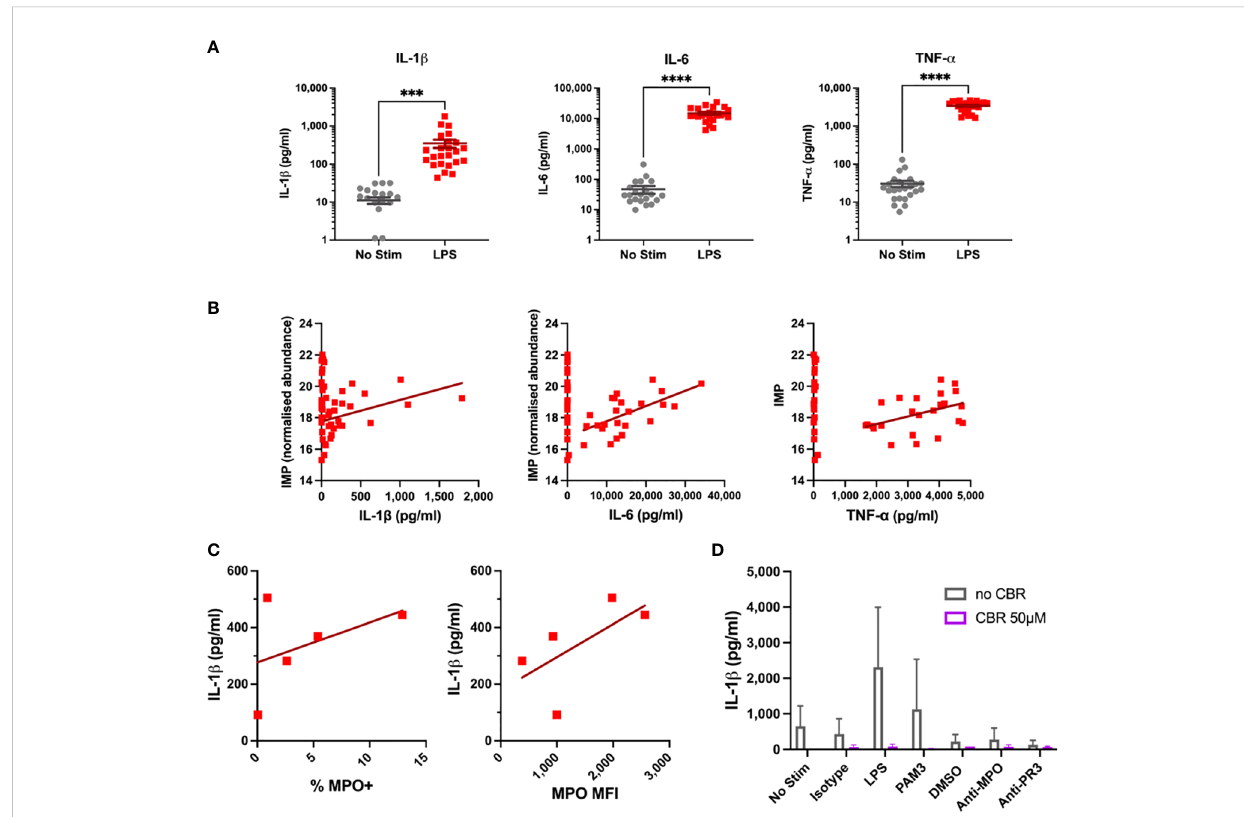
FIGURE 4 Cytokine and Flow Results for LPS-Stimulated Monocytes. (A) IL-1 b , IL-6, TNF- a levels were measured in supernatants of monocytes by ELISA after four hour LPS stimulation. (B) Cytokine levels are correlated with IMP concentration in primary monocytes. (C) Correlation of baseline MPO surface expression with IL-1 b production in stimulated primary monocytes. (D) Effects of serine synthesis pathway inhibition on IL-1 b production in LPS- Stimulated Monocytes. *** p < 0.001, **** p <